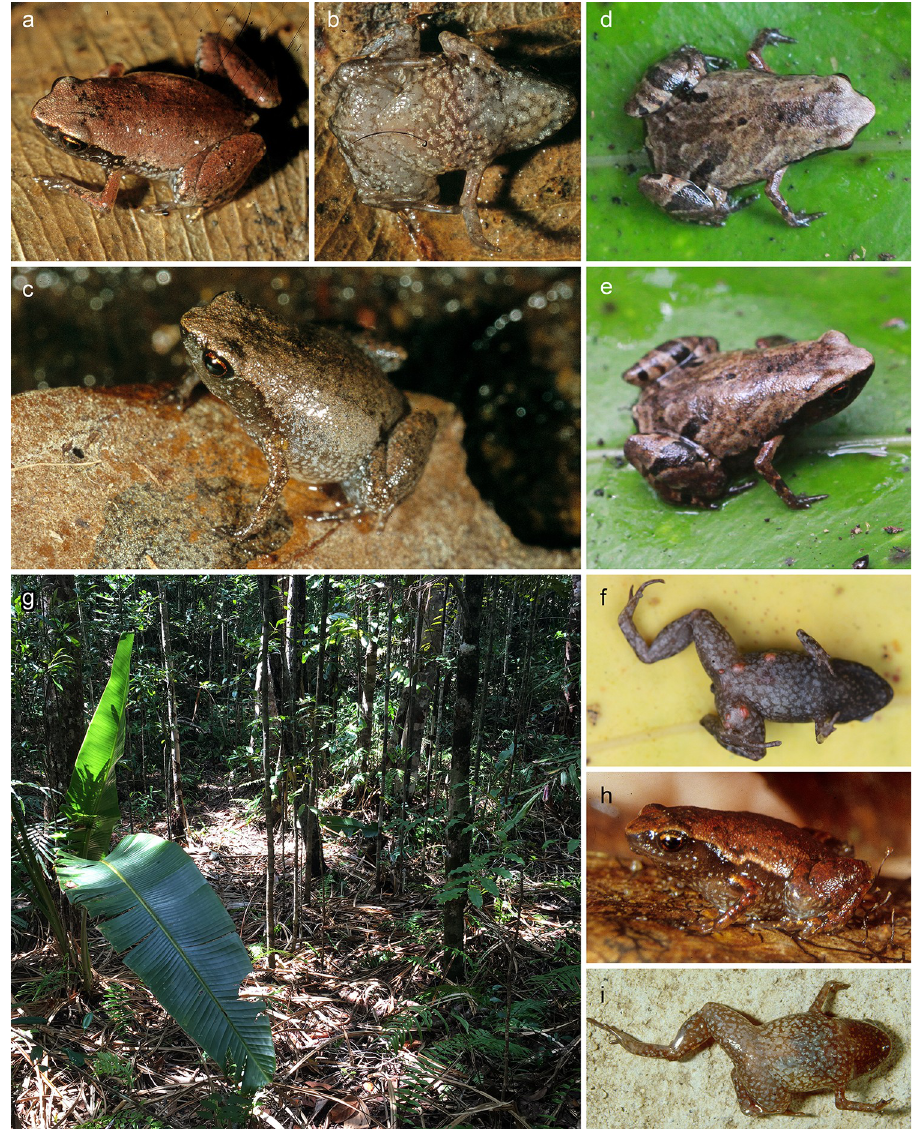
Fig 7. Mini scule gen. et sp. nov. in life and its habitat in Sainte Luce Reserve. (a, b) ZSM 5943/2005, holotype, in (a) dorsolateral and (b) ventral view. Black lines in the two pictures are scanning artefacts from damaged analogue slides. (c) Probably ZSM 5942/2005, paratype, in dorsolateral view. (d-f) ZSM 265/2018 (SHR 09112018) in (d) dorsal, (e) dorsolateral, and (f) ventral view. Note the numerous pink cf. Endotrombicula mites on the abdomen and legs. (g) Habitat in Sainte Luce Special Reserve. (h, i) Mini cf. scule from Nahampoana, ZFMK 53775 in (h) lateral and (i) ventral view.